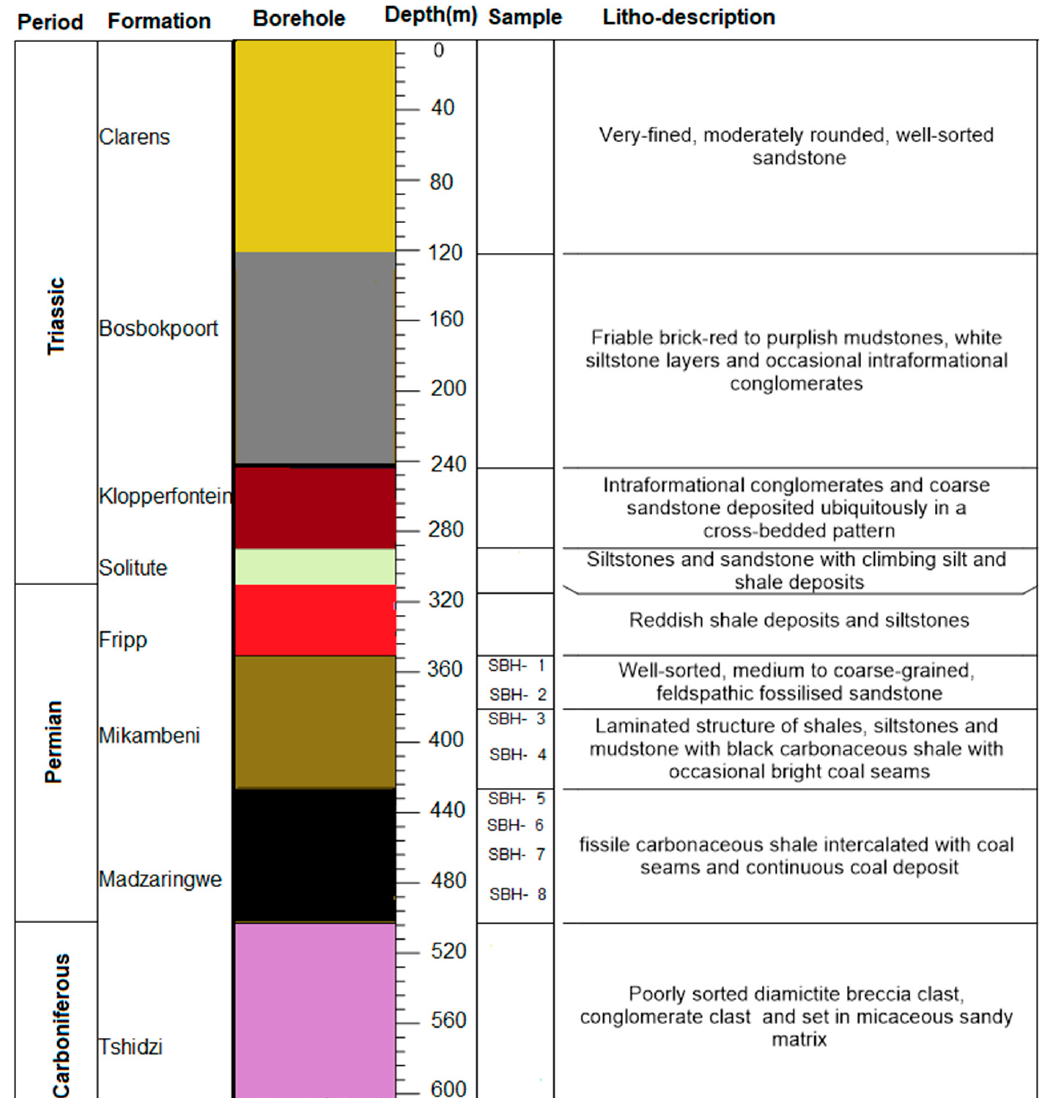
Figure 2. Stratigraphic column of the studied borehole showing lithologic description and carbonaceous shale sampling depth.